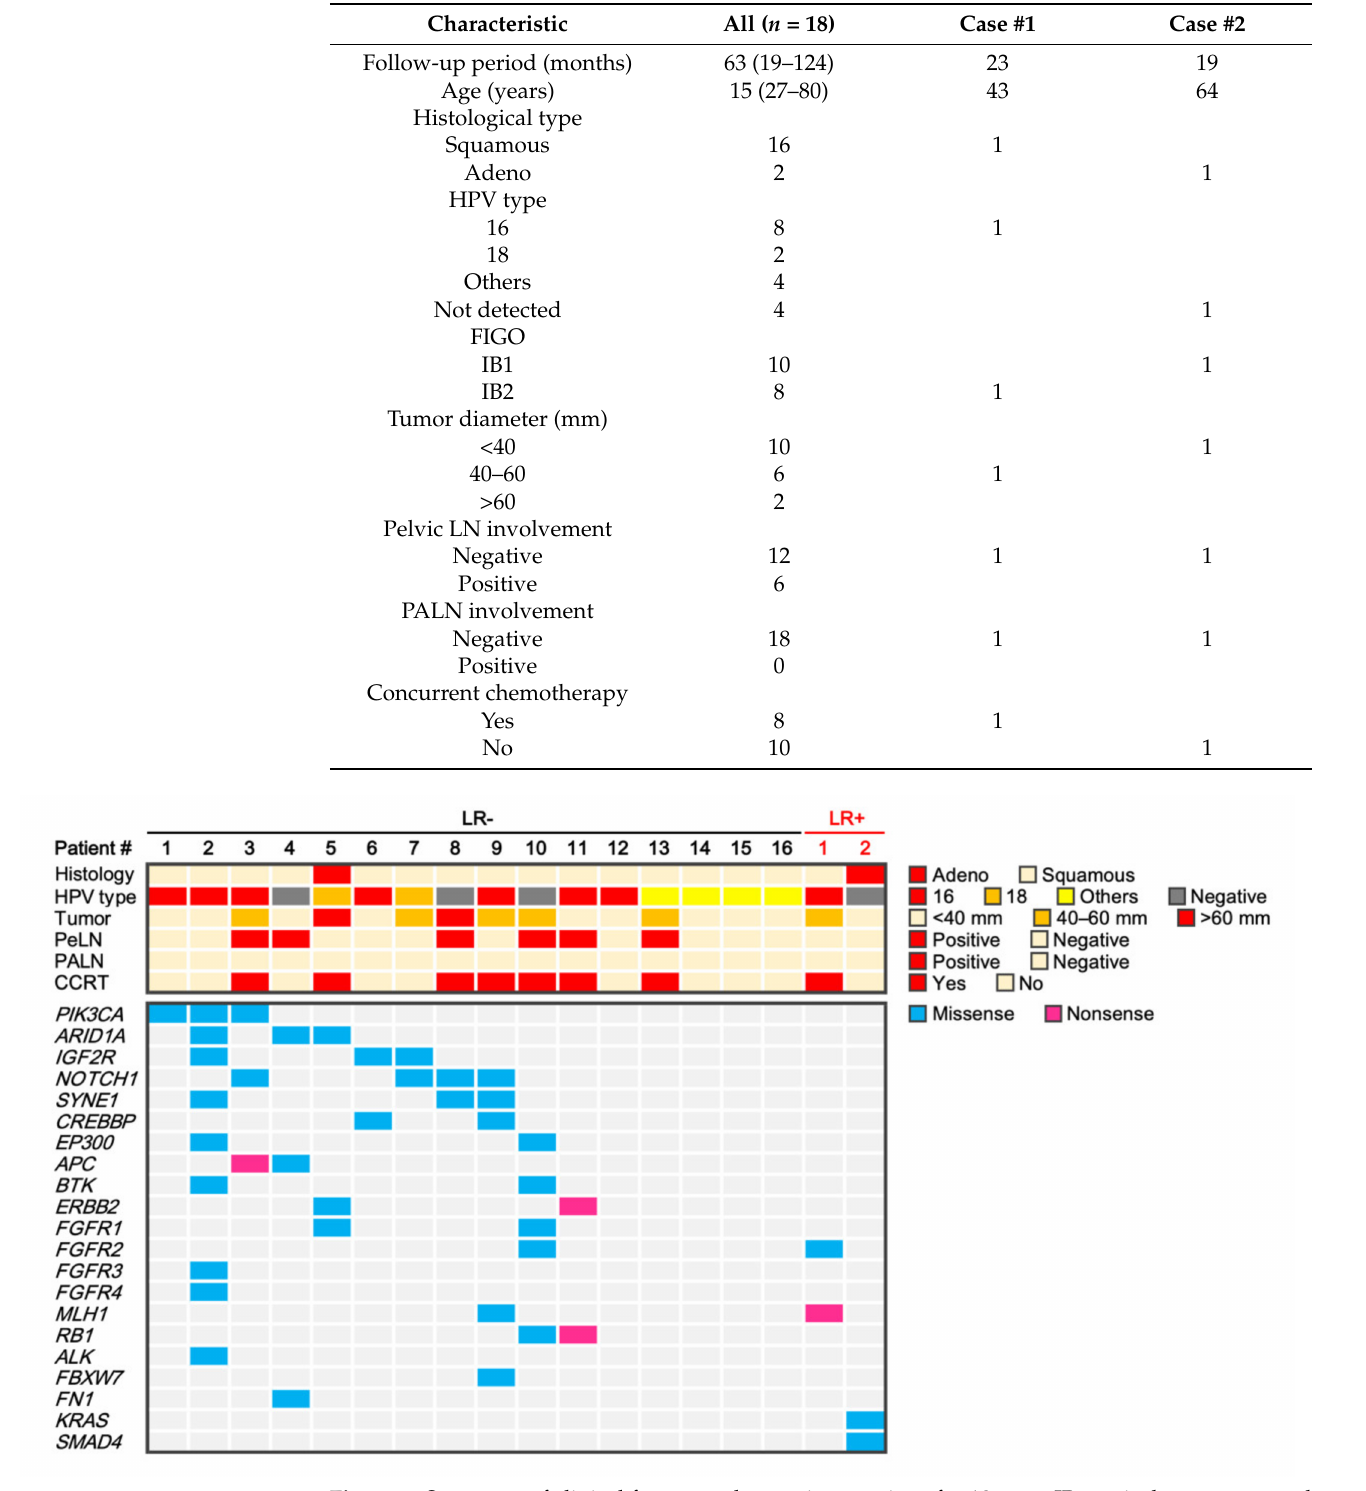
Figure 1. Summary of clinical factors and somatic mutations for 18 stage IB cervical cancers treated with radiotherapy. Adeno, adenocarcinoma; HPV, human papilloma virus; LR, local recurrence; PeLN, pelvic lymph nodes; PALN, para-aortic lymph nodes; Squamous, squamous cell